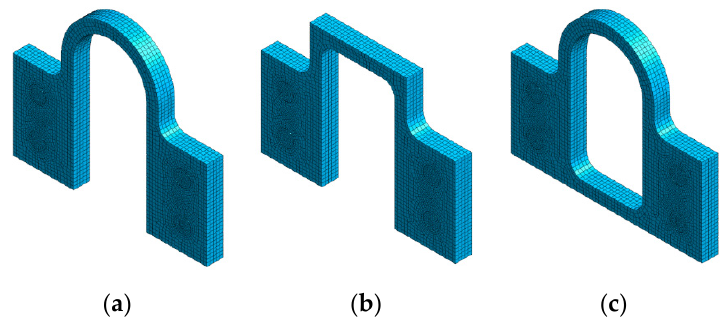
Figure 10. FE modeling of steel dampers used in this study: ( a ) SD1; ( b ) SD2; ( c ) SD3.